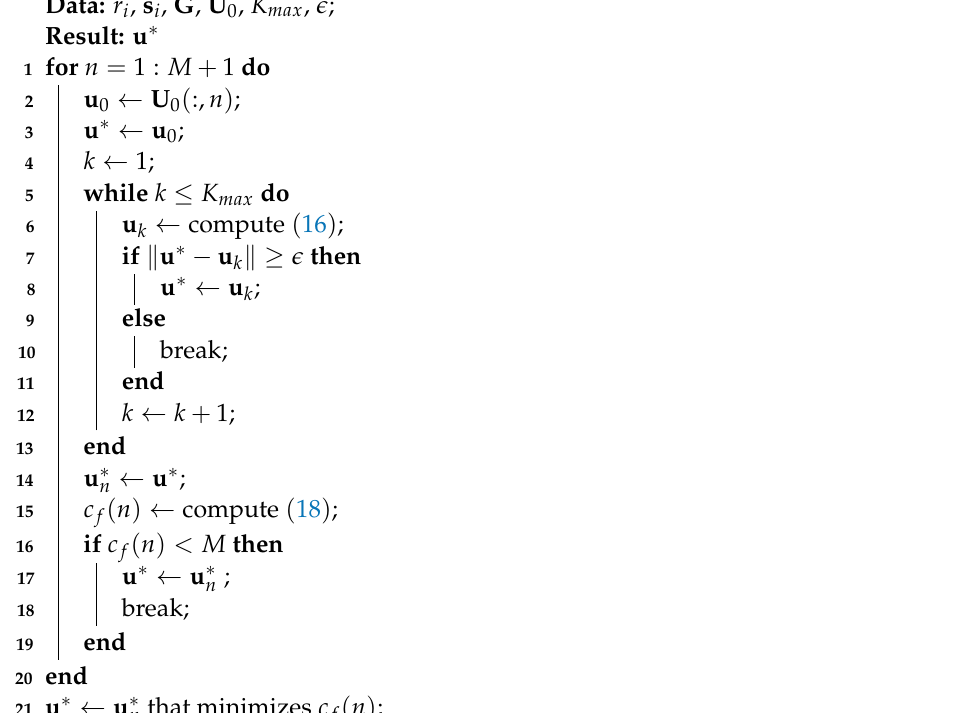
Algorithm 1: Localization with scenario 1: accurate sensor